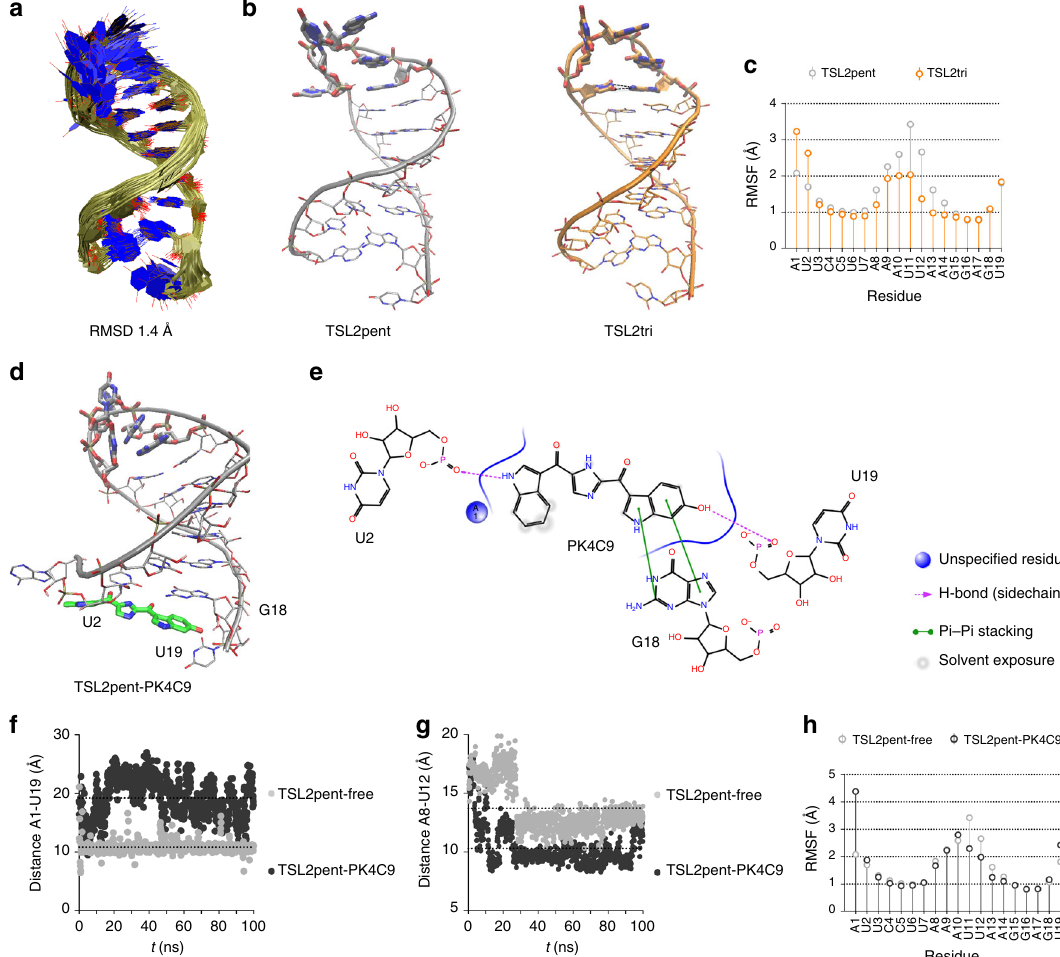
Fig. 6 PK4C9 directly causes opening of 5 ′ ss TSL2 residues and indirectly induces triloop conformation. a Bundle of 40 NMR structures of TSL2. b Representative ligand-free pentaloop (TSL2pent, silver) and triloop (TSL2tri, orange) NMR structures of TSL2. c Comparison of the mobility of TSL2pent and TSL2tri residues in 100-ns molecular dynamics (MD) trajectories, measured by root-mean-square fl uctuation (RMSF). d Representative model structure of the binding mode of PK4C9 (green) to TSL2pent (TSL2pent-PK4C9, grey), taken from the most abundant cluster of a 100-ns MD trajectory. e Close-up 2D view of the binding mode of PK4C9. Interactions were plotted using the Maestro software. f Graph showing the PK4C9-induced increase in the distance between the C1 ’ atoms of residues A1 and U19 throughout the MD trajectory, as an indicator of terminal TSL2 opening. g Graph showing the PK4C9-induced decrease in the centre of mass distance between residues A8 and U12 throughout the MD trajectory, as an indicator of triloop formation. h Per-residue comparison of the mobility of TSL2pent-free and TSL2pent-PK4C9, measured by root-mean-square fl PK4C9 in 0.5mL of standard nutritive media. Larvae were free fed with PK4C9 for of TO-PRO-1 with RNA and ( D ) intensity of the TO-PRO-1 alone. When Ribo- 5 days. Tubes were kept at 25°C and fl ies were collected 24h after hatching for Green was used instead of TO-PRO-1, 300 nM of dye was used, with fl uorescence homogenisation. emission read in a LightCycler ® qPCR instrument using Sybr Green fi lters. Reverse transcription (RT)-PCR . Total RNA was extracted using the RNeasy Cell culture . HeLa cells were a gift from Prof. U. Rüegg (University of Geneva, mini kit with on-column DNase digestion (Qiagen). Between 0.5 and 1 μ g of RNA Switzerland). HeLa cells were cultured in DMEM medium with 10% FBS and 1% were used for reverse transcription with Super Script II (Invitrogen) or the High- antibiotics (penicillin and streptomycin). ND36091A, GM03814B and GM03813C fi broblasts were obtained from the Coriell Institute for Medical Research, and Capacity cDNA Reverse Transcription Kit (Applied Biosystems), using random hexamers (cultured cells) or a gene-speci fi c primer 5 ′ -CAGCGTAAGT- grown in MEM medium with 15% FBS, 1% antibiotics (penicillin and strepto- GATGTCCACCT-3 ′ ( Drosophila ). A total of 100 ng of cDNA were used as tem- mycin) and 2 mM glutamine (freshly added). All lines were kept in a humidi fi ed plate in semi-quantitative PCR with GoTaq polymerase (cultured cells; Promega) incubator at 37 °C in 5% CO 2 . For all RNA and protein extractions, 4× 10 5 cells or 2×PCR Super Master Mix ( Drosophila , Biotool). Three biological replicates and were seeded per well per triplicate in six-well plates (volume 2mL) and grown to three technical replicates per biological replicate were obtained, unless stated 80% con fl uence. DNA transfection of pCI- SMN2 E6 − to − 8 minigenes 16 in HeLa was otherwise. Primer sequences, and PCR conditions are described in Supplementary performed using X-tremeGENE HP Transfection Reagent (Roche Life Science) and Table 4. Bands were resolved in 3% agarose gels at 4 °C for 90 min. Representative 1 μ g of plasmid DNA. After 24 h, treatment was added to the wells. In non- full agarose gel images supporting our main fi ndings are shown in Supplementary transfected cells ( fi broblasts), compounds were directly added to the wells once Fig. 13. Quanti fi cation of band intensity was performed on ImageJ. The effect of 80% cell con fl uence was reached. Fibroblasts and HeLa were regularly checked for TSL2 mutations on PK4C9 splicing modi fi er activity is shown as the percentage of mycoplasma contamination. maximum E7 increment possible (% MIP), de fi ned by Eq. (2): Drosophila . A total of 10 – 12 fi rst-instar larvae expressing the UAS-SMN2:luc % MIP ¼ minigene under the control of the D42 promoter ( D42-Gal4 , Bloomington #8816) were transferred per triplicate into tubes containing 0.5% DMSO (control) or